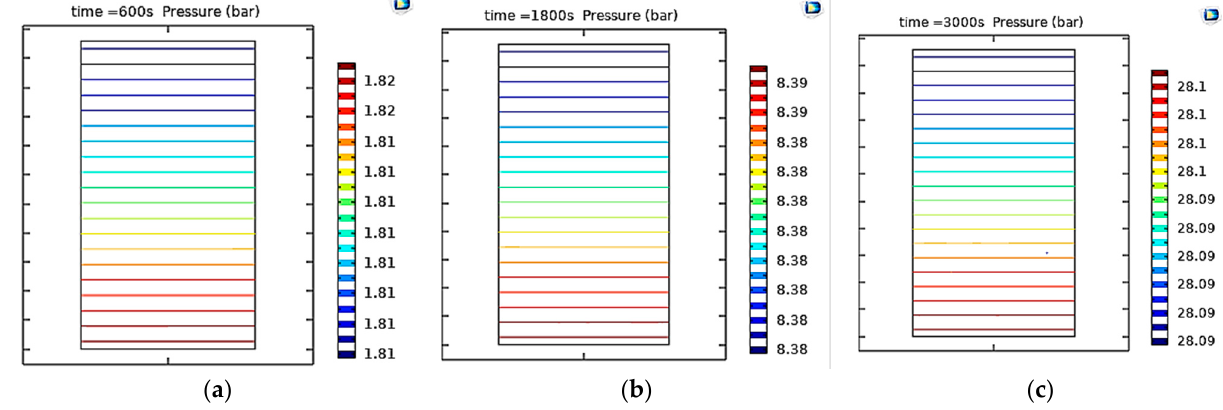
Figure 8. Pressure distribution inside the reactor at three different times: ( a ) 600 s, ( b ) 1800 s and ( c ) 3000 s.